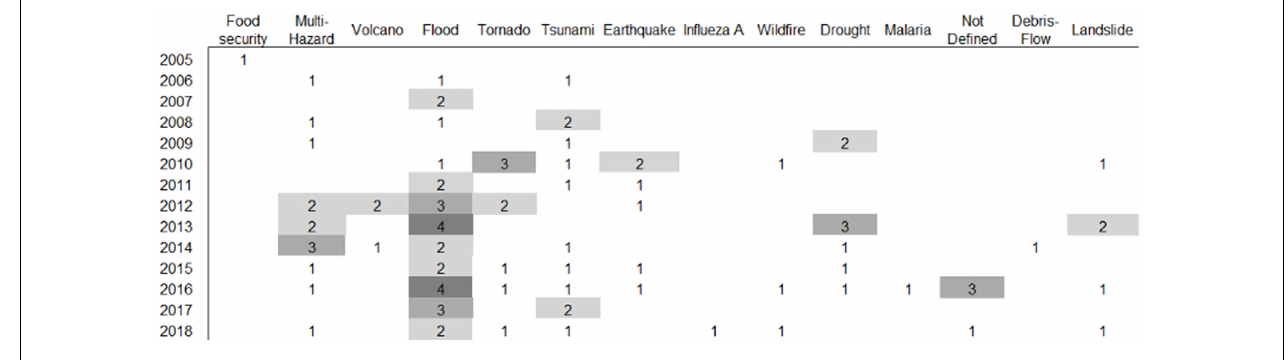
FIGURE 6 | Distribution of selected studies per type of hazard, per year.